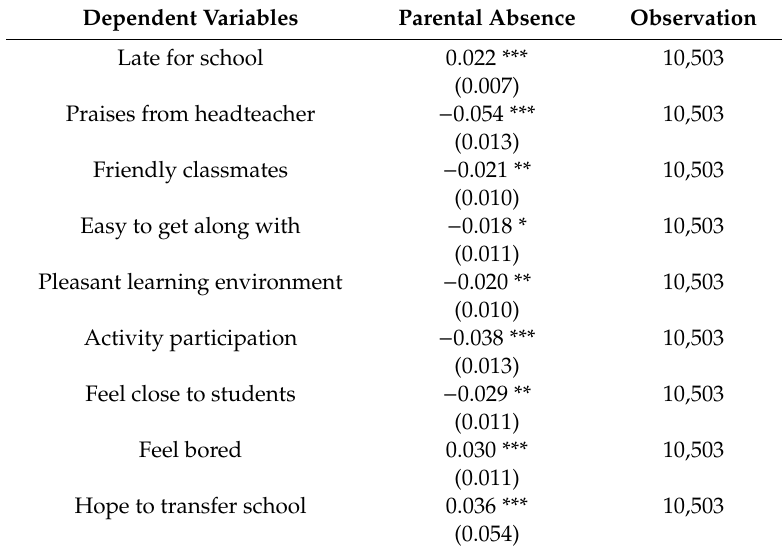
Table 9. The e ff ect of parental absence on the perception of campus life. Dependent Variables Parental Absence Observation Late for school 0.022 *** 10,503 (0.007) Praises from headteacher − 0.054 *** 10,503 (0.013) Friendly classmates − 0.021 ** 10,503 (0.010) Easy to get along with − 0.018